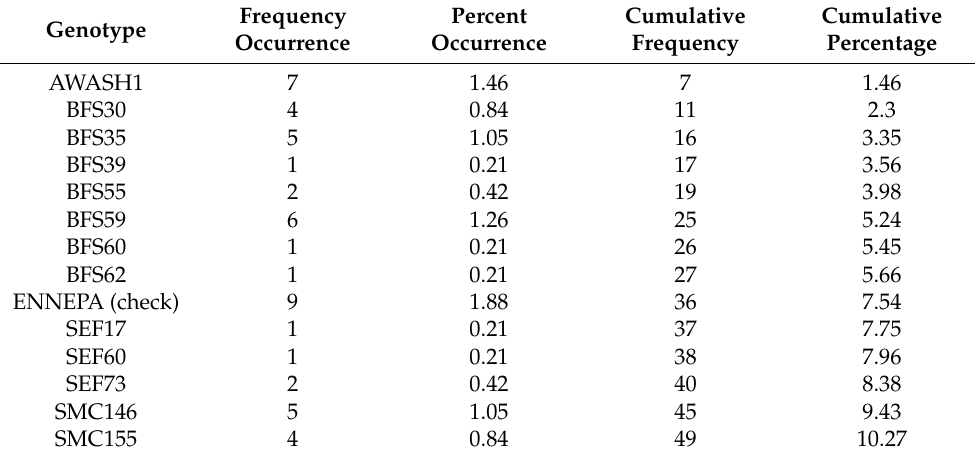
Table 6. Non-flowering frequency of drought-tolerant common bean genotypes during termi- nal